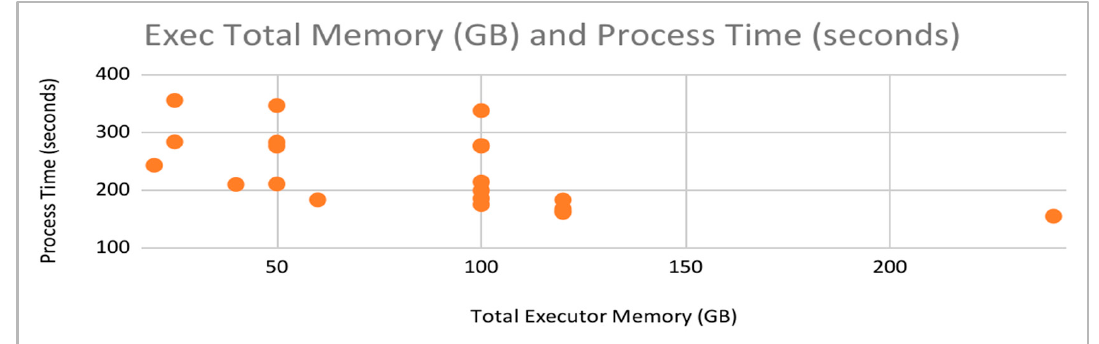
Figure 6. Process Times vs. Memory per Executor.